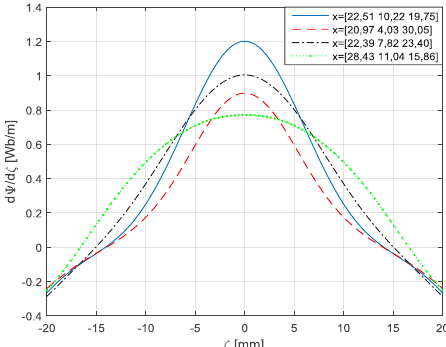
Fig. 2. Variations of objective function: a) vs. x 1 and x 2 , b) vs. x 1 and x 3 , c) vs. x 2 and x 3 .